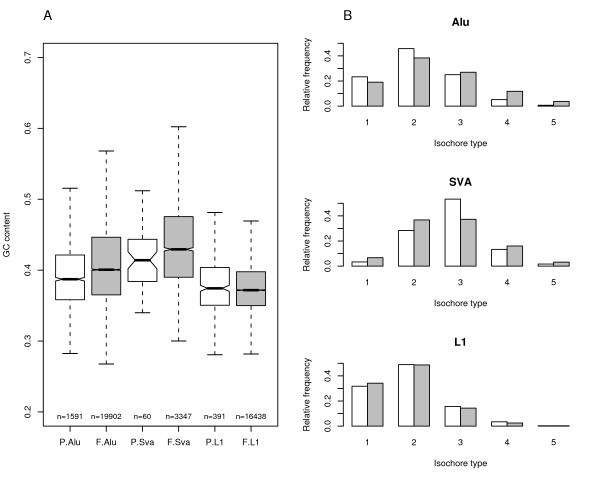
Analysis of fixed versus polymorphic retrotransposon insertions. (A) Analysis of average GC content flanking polymorphic (P, white) and fixed (F, gray) retrotransposons. GC content was calculated in 5 kb flanking the repeat. The number of repeat instances is also indicated. GC content is significantly higher for regions flanking fixed compared to polymorphic Alus ; the same holds for SVAs. (B) Analysis of polymorphic (white) and fixed (gray) retrotransposon relative frequency in different isochores (L1 to H3, ordered from 1 to 5, as described in [20]). Fixed Alus are significantly enriched in heavy isochores compared to polymorphic instances.